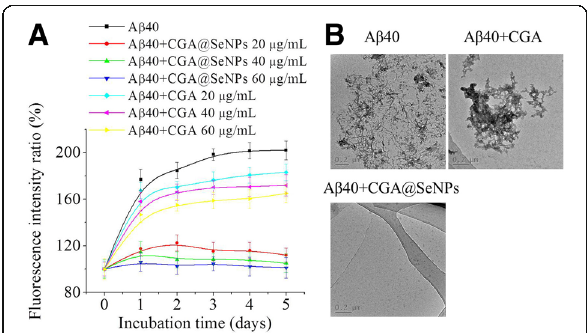
Fig. 3 Inhibition effect of CGA@SeNPs on A β 40 fibrillation. a ThT fluorescence of A β 40 fibril formation in the presence or absence of nanoparticles/CGA from 0 to 5 days. A β 40 = 35 μ M, nanoparticles/ CGA = 20, 40, and 60 μ g/mL. b Morphology of A β 40 incubated with or without nanoparticles or CGA for 3 days. A β 40 = 35 μ M, nanoparticles/CGA = 60 μ